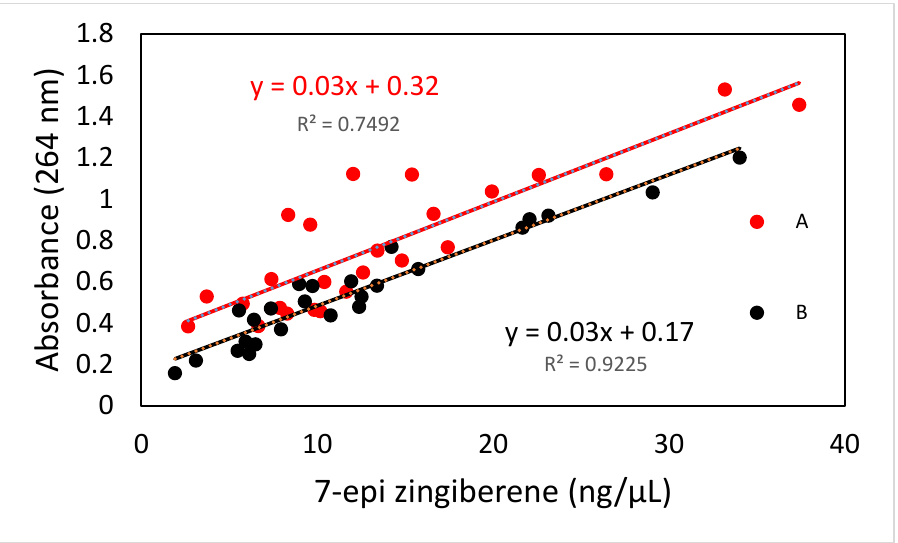
Figure 8. Average absorbance spectrum in the 200–350 nm region for leaflet washes obtained from the BC2F3 generation plants. The vertical dashed line identifies 264 nm, the λ max of isolated 7-epi zingiberene.